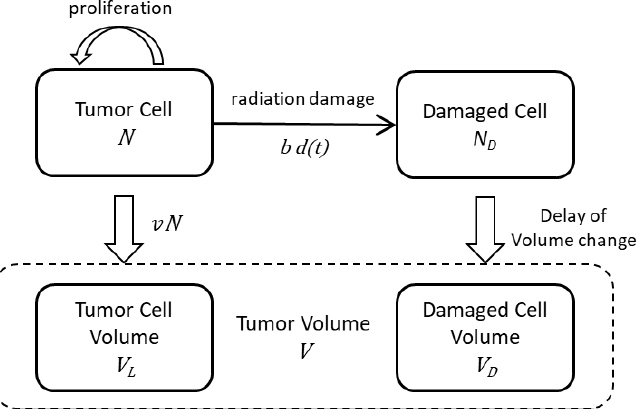
Figure 5. The schematic view of the proposed model. We assume that the cancer volume consists of the viable tumor cell volume, V L , and the damaged cell volume, V D , which are related with the corresponding numbers, N and N D . The tumor cells proliferate with the growth rate, λ , modified slightly by the damage of cancer tissue due to radiation. The cell damage is caused by the radiation with the radiation dose, d ( t ).